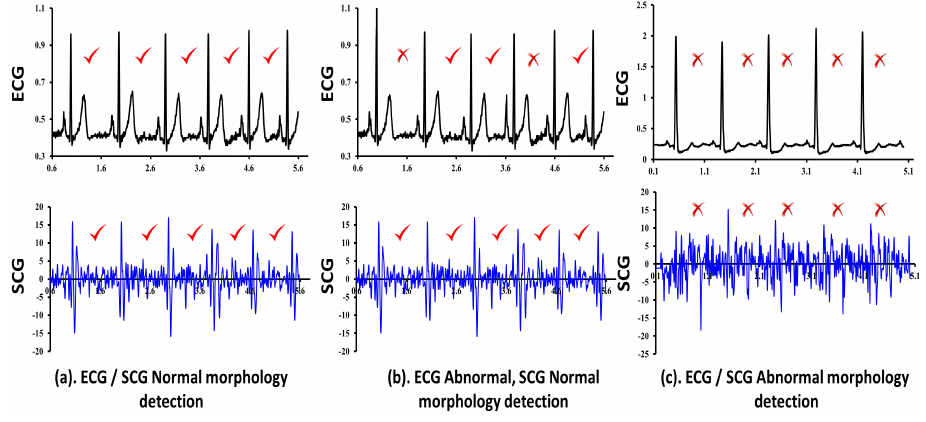
Figure 9. Combined evaluation of ECG and SCG signals using set of five cardiac